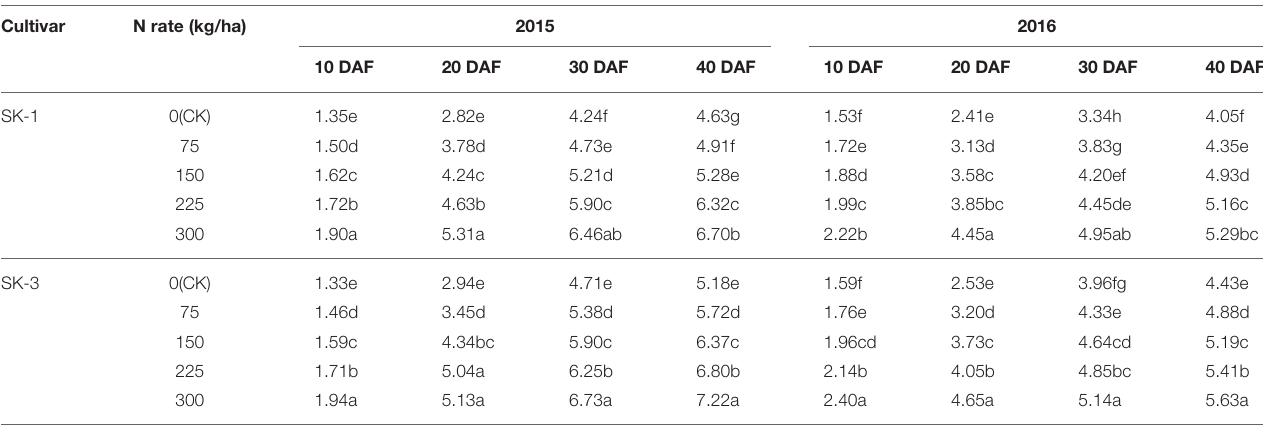
TABLE 3 | The effect of the nitrogen level on the boll dry weight (g) of the two Bt cotton cultivars in 2015 and 2016. Cultivar N rate (kg/ha)